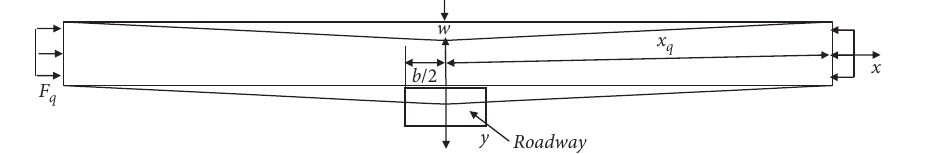
Figure 3: Mechanical model of the vertical and horizontal bending.